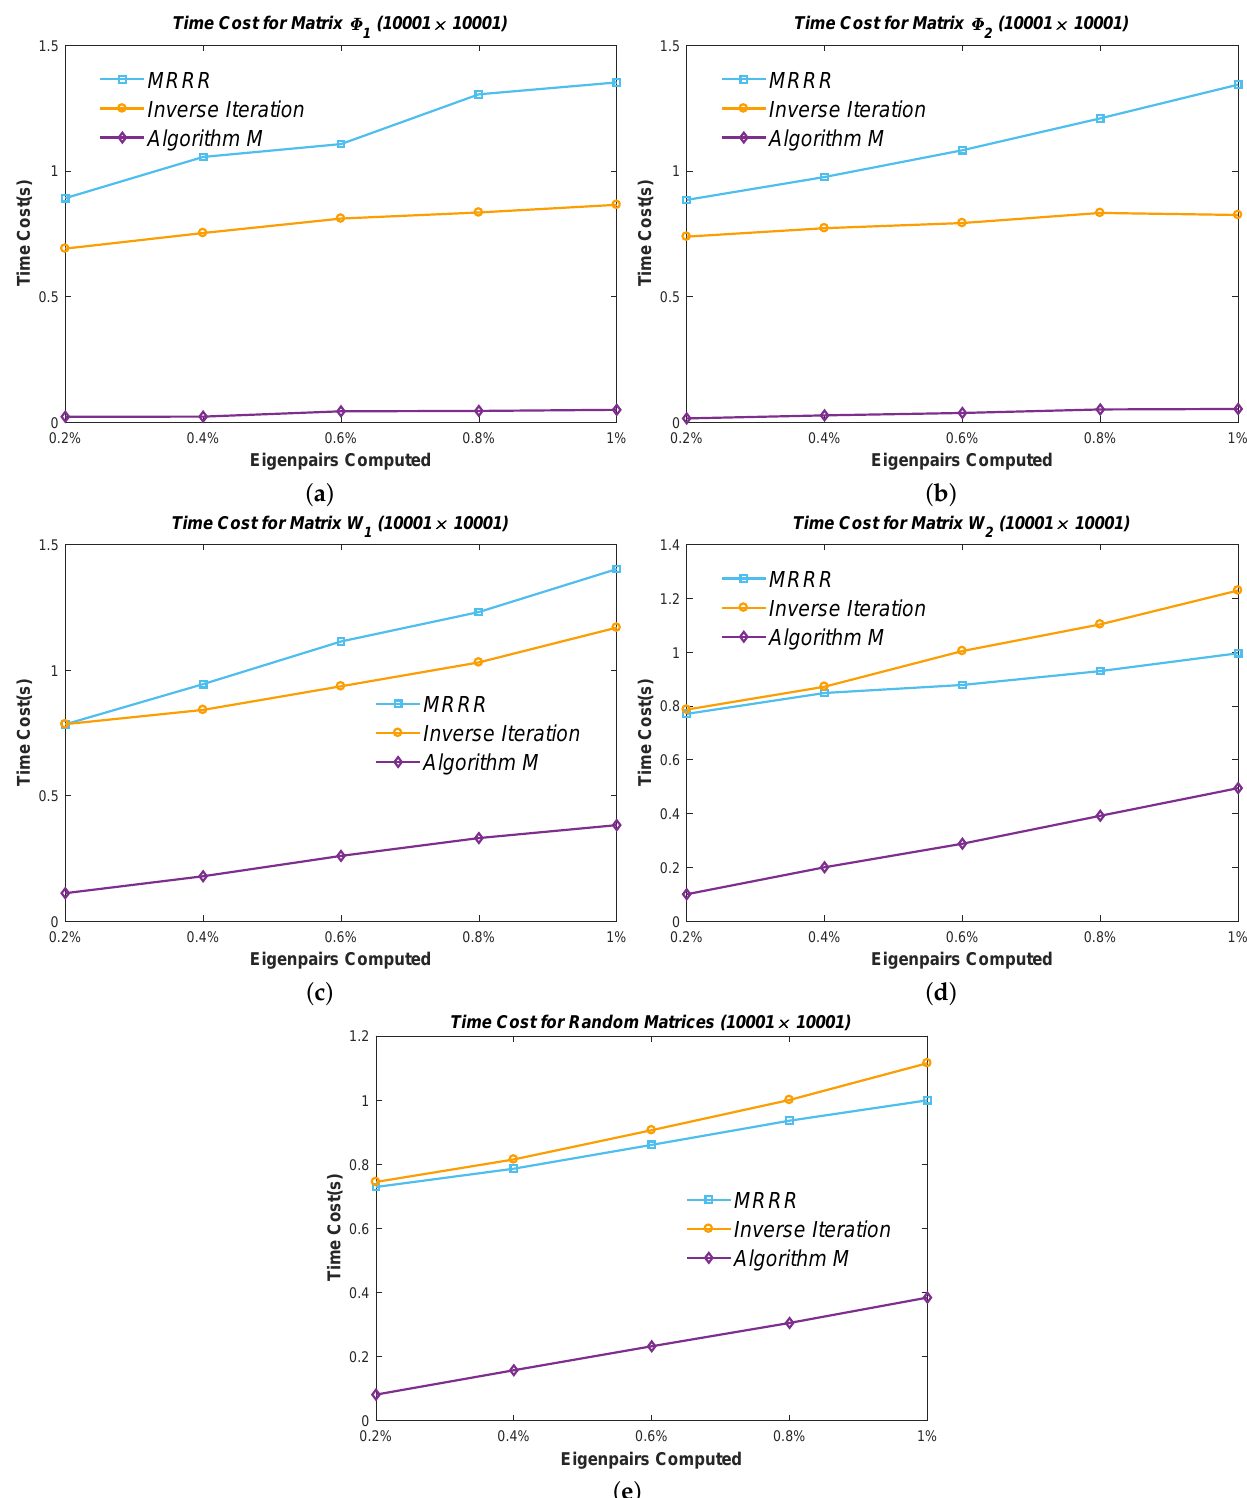
Figure 16. The time cost for minor eigenpairs in 10001 W 1 ; ( d ) Matrix W 2 ; ( e ) Random